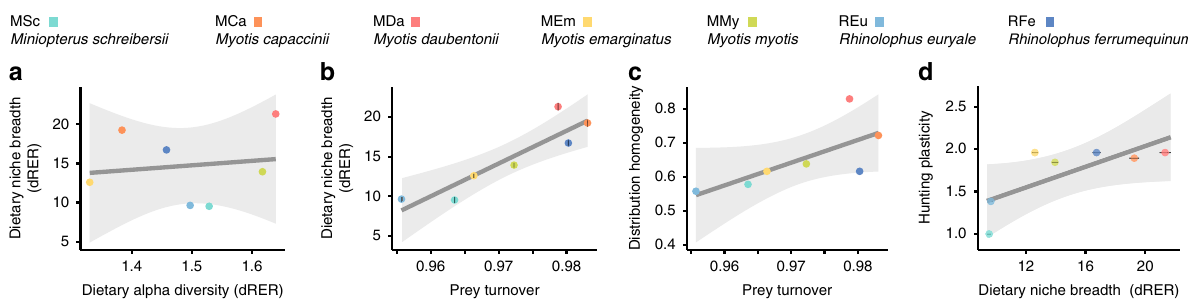
Fig. 3 Relationships of dietary, spatial and behavioural traits of species. a Dietary alpha diversity of species shows no linear correlation with dietary niche breadth. b Dietary niche breadth exhibits a signi fi cant linear correlation with prey turnover. c Distribution homogeneity shows a borderline linear trend with prey turnover. d Dietary niche breadth exhibits a signi fi cant linear correlation with